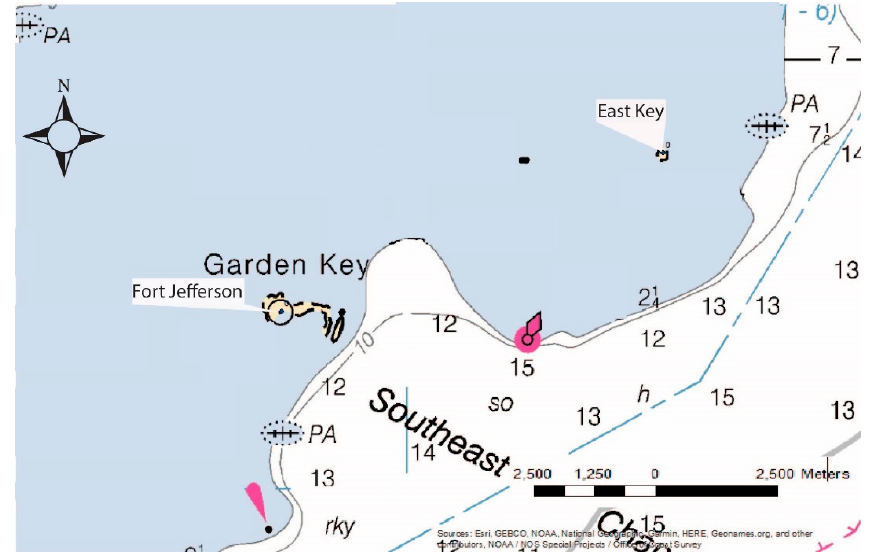
Figure 1. Map showing location of East Key Construction Wreck relative to Garden Key and Fort Jefferson.